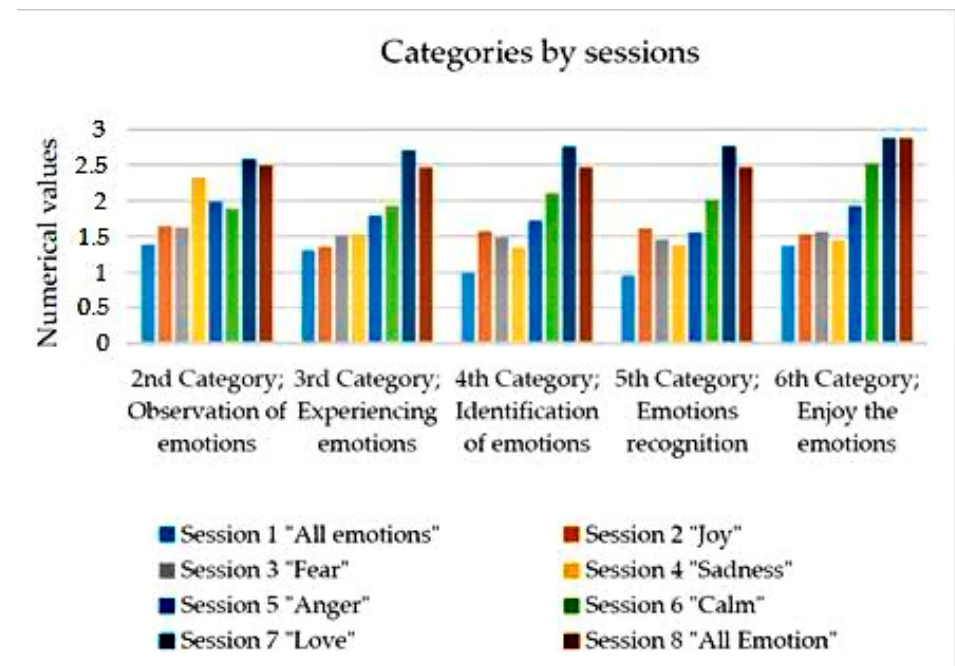
Figure 2 . Categories by sessions . Figure 2. Categories by